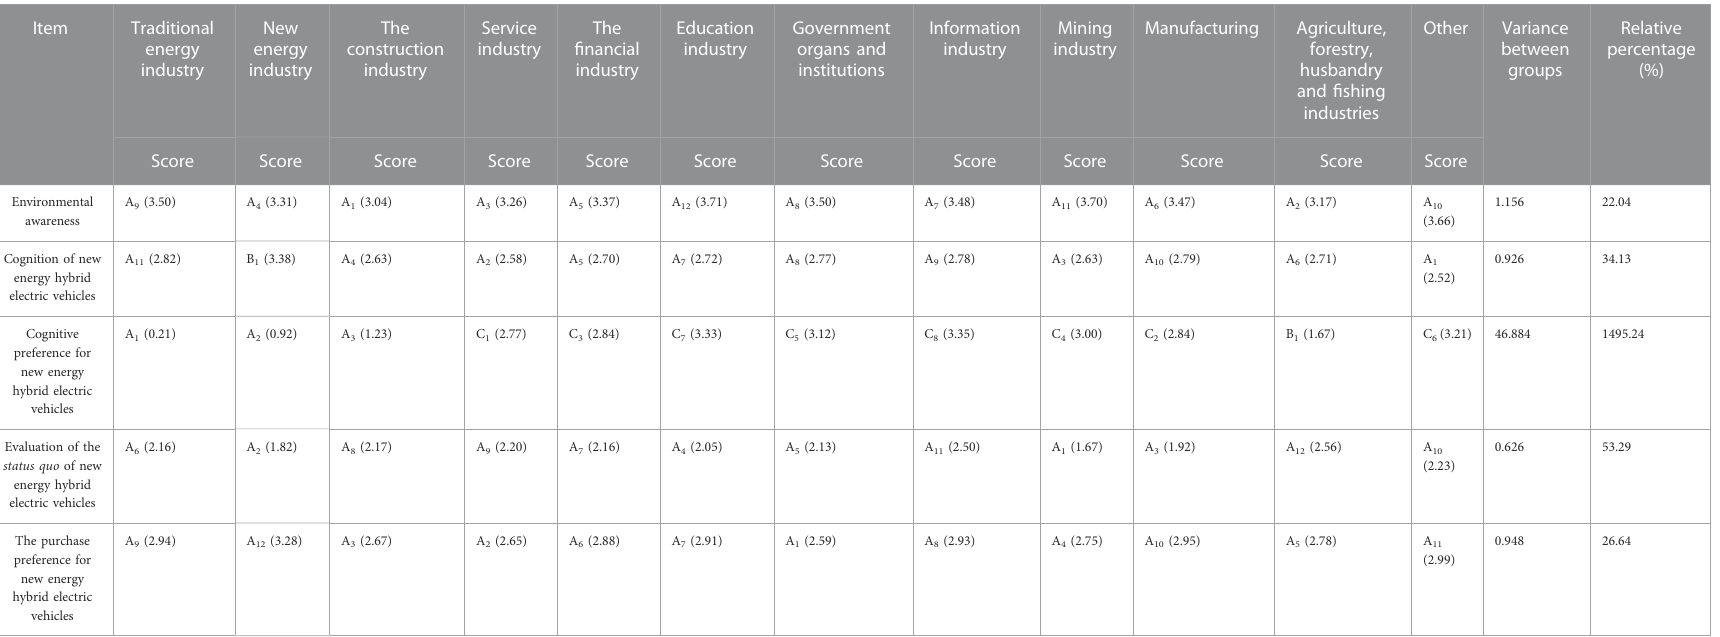
TABLE 10 Test results and ranking of different